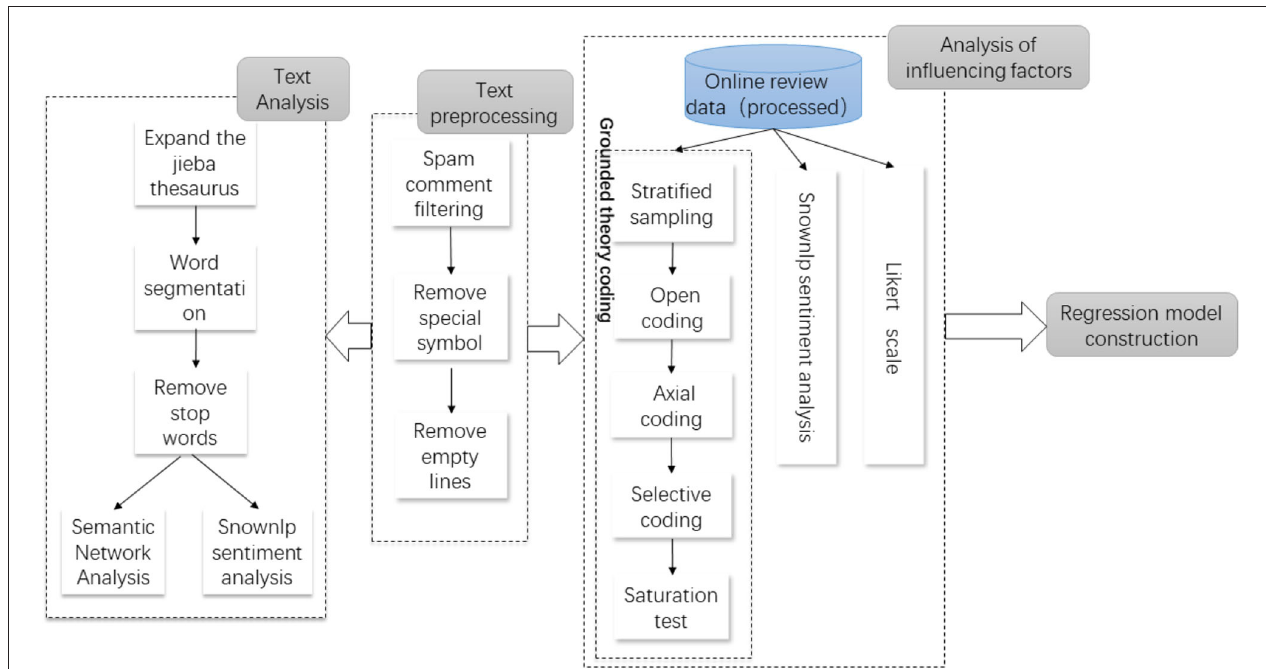
FIGURE 1 | Research